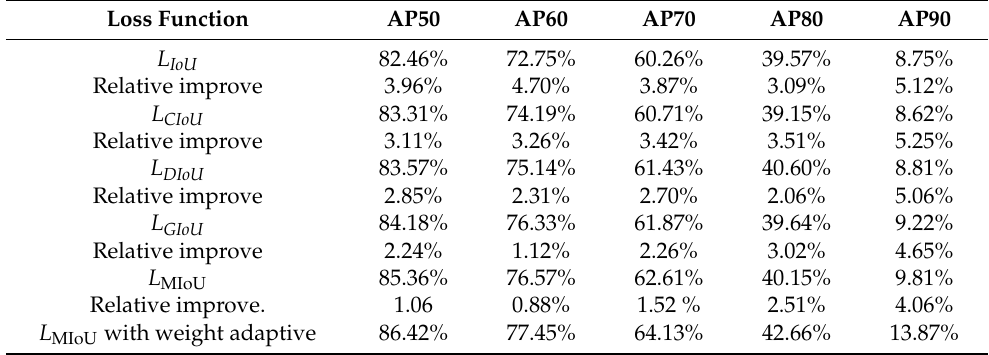
Table 3. Quantitative comparison of M-O SiamRPN using L IoU , L CIoU , L DIoU , L GIoU , L MIoU .